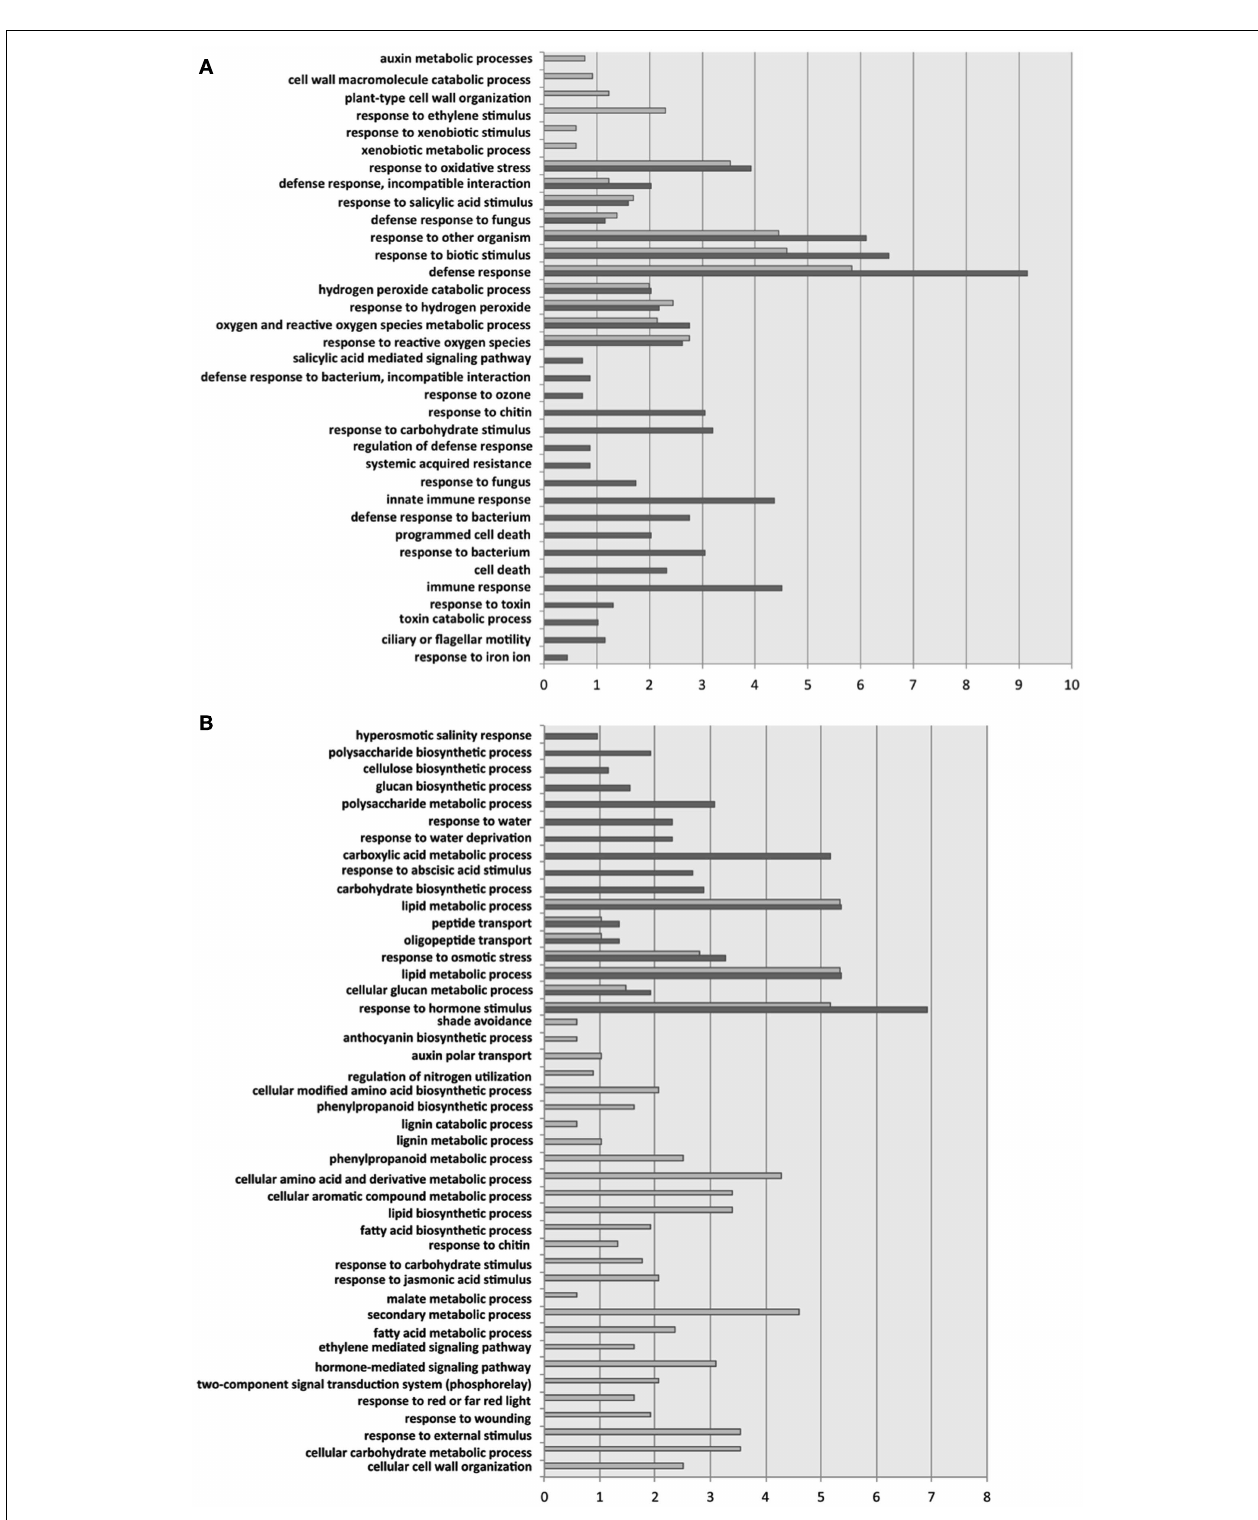
FIGURE 3 | Significant GO categories for biological processes identified for Groups 1 (Di-2, L er -0 and St-0; light gray bars) and 2 (Ei-2 andWt-1; dark gray bars). (A) For up-regulated genes. (B) For down-regulated genes.The length of the bars represents the percentage of enrichment on each biological